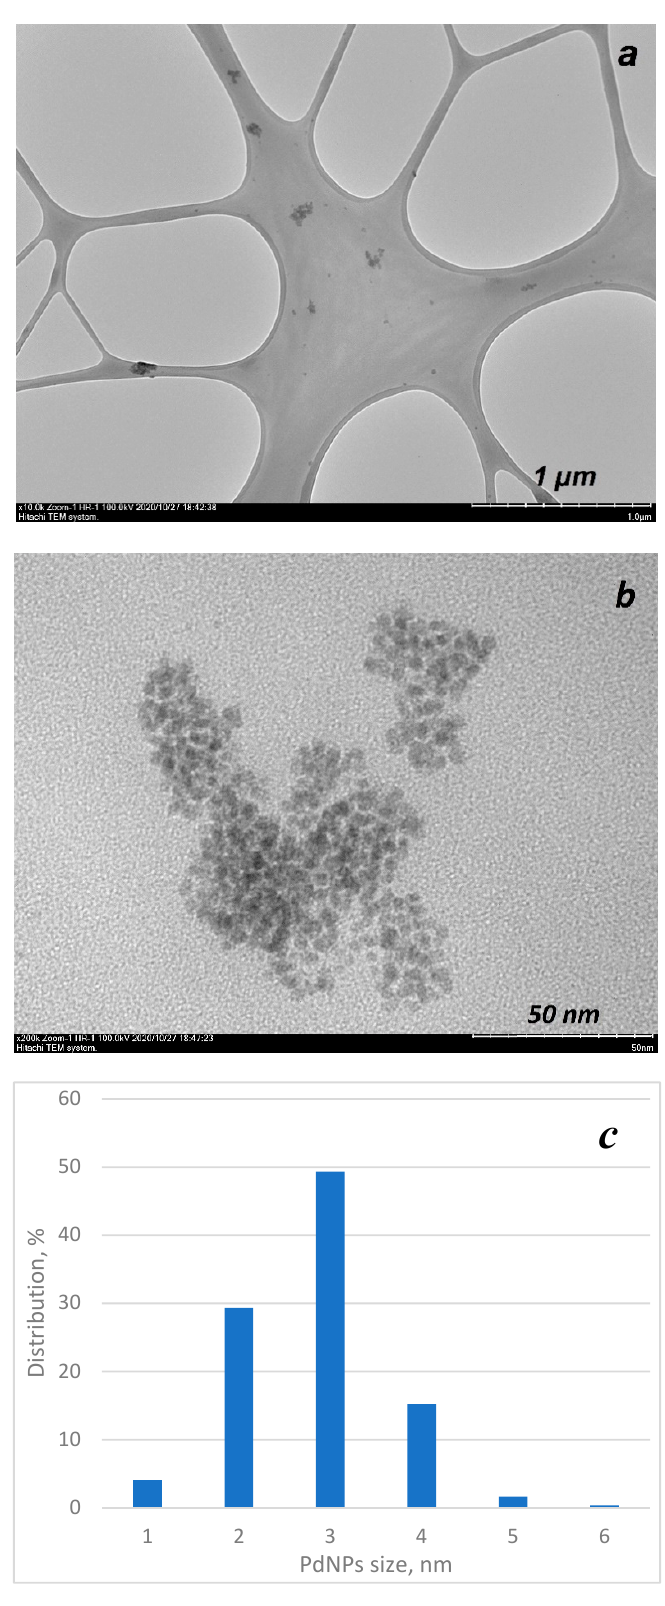
Figure 6. TEM of PdNPs using the “nanofishing” technique ( a , b ) and size distribution graph ( c ).